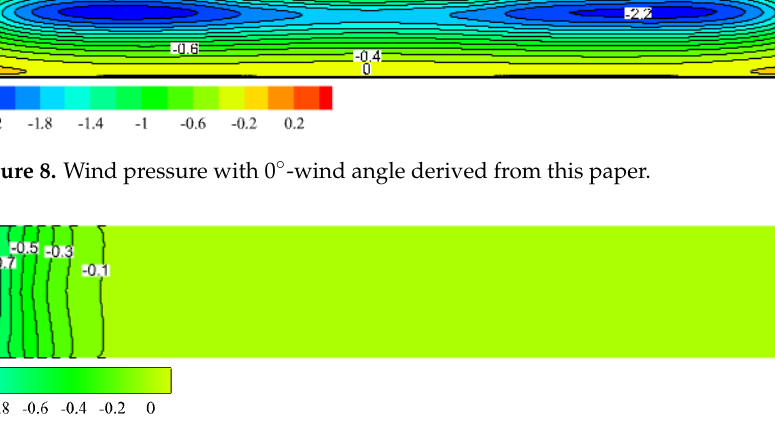
Figure 9. Wind pressure with 90 ◦ -wind angle derived from this